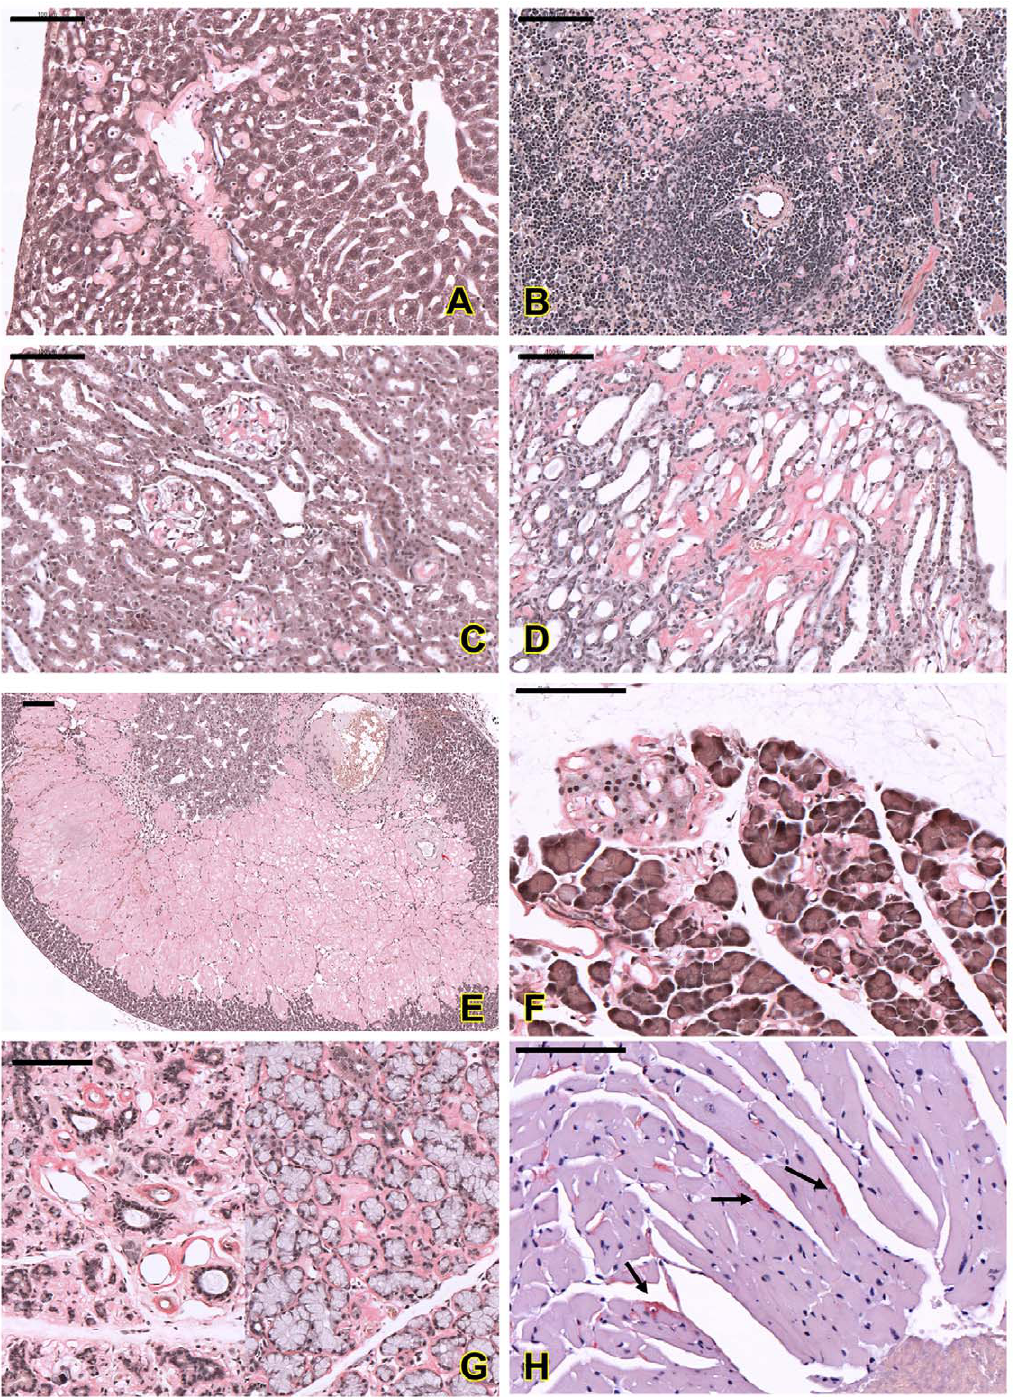
Figure 6. Histopathological analysis of amyloids in different organs of the affected mice. Amyloid deposition in sinusoids and around the portal vein in liver (A); in red pulp and peri-white pulp area in spleen (B). In kidney, amyloid was found in glomerulus (C) and renal tubules (D). Amyloid was also found in adrenal cortex and medulla (E), islet of Langerhans and around the acinar cells of pancreas (F), salivary glands (G) and myocardium (arrows in H). All sections were stained with Congo red; amyloid deposits appeared pink-red color with this staining. Bar=100 m m.